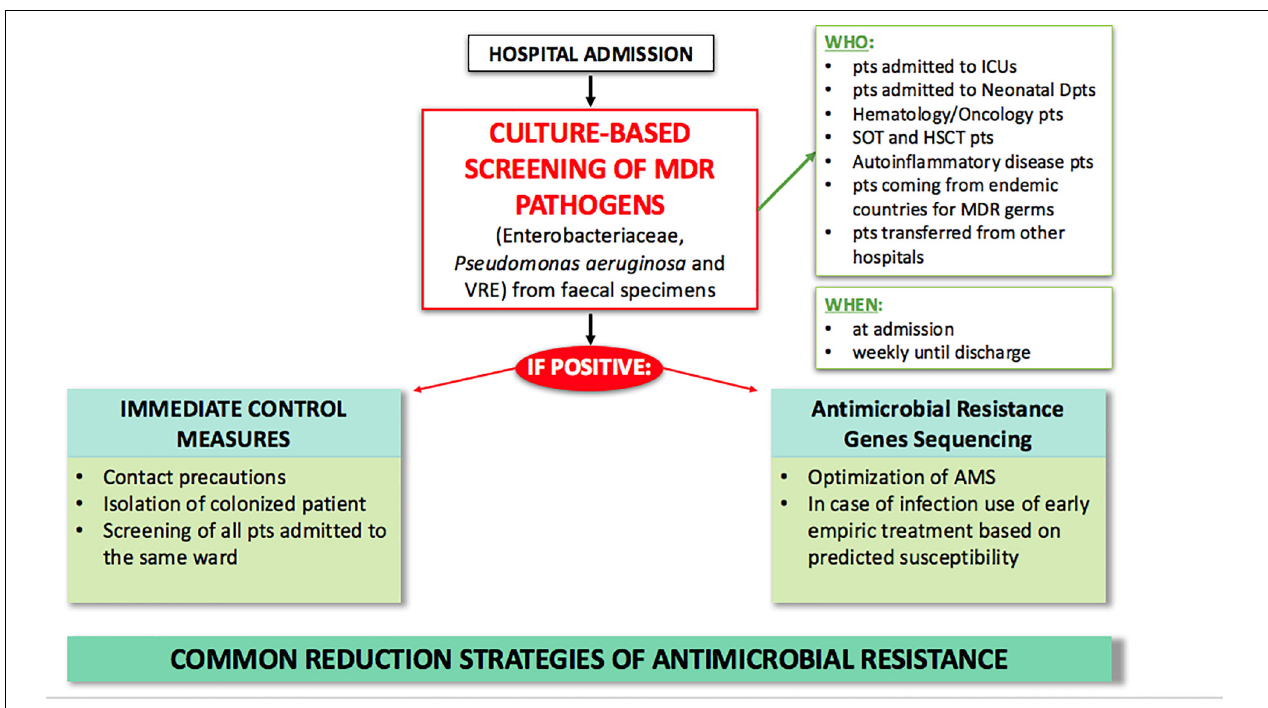
FIGURE 1 | Current strategies for MDR antimicrobial clinical and laboratory stewardship in hospital settings. AMS, antimicrobial stewardship; FMT, fecal microbiota transplantation; HSCT, hematopoietic stem cell transplantation; ICU, intensive care unit; MDR, multi-drug resistant; pts, patients; SOT, solid organ